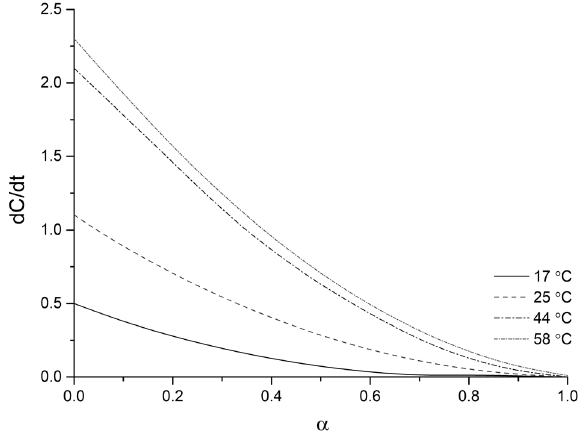
Figure 6: The dependence of E